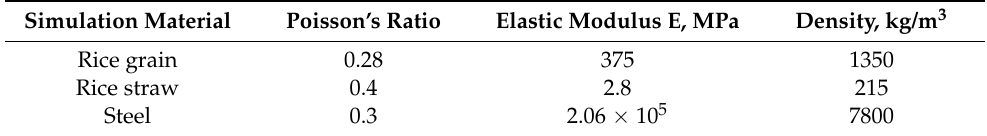
Figure 3. Schematic diagram of simulation model of threshing device: 1—top cover; 2—threshing cylinder; 3—concave grid; 4—reception box; 5—guard plate. Table 2. Material parameters setting in the DEM simulation [6]. Table 2. Material parameters setting in the DEM simulation [6].